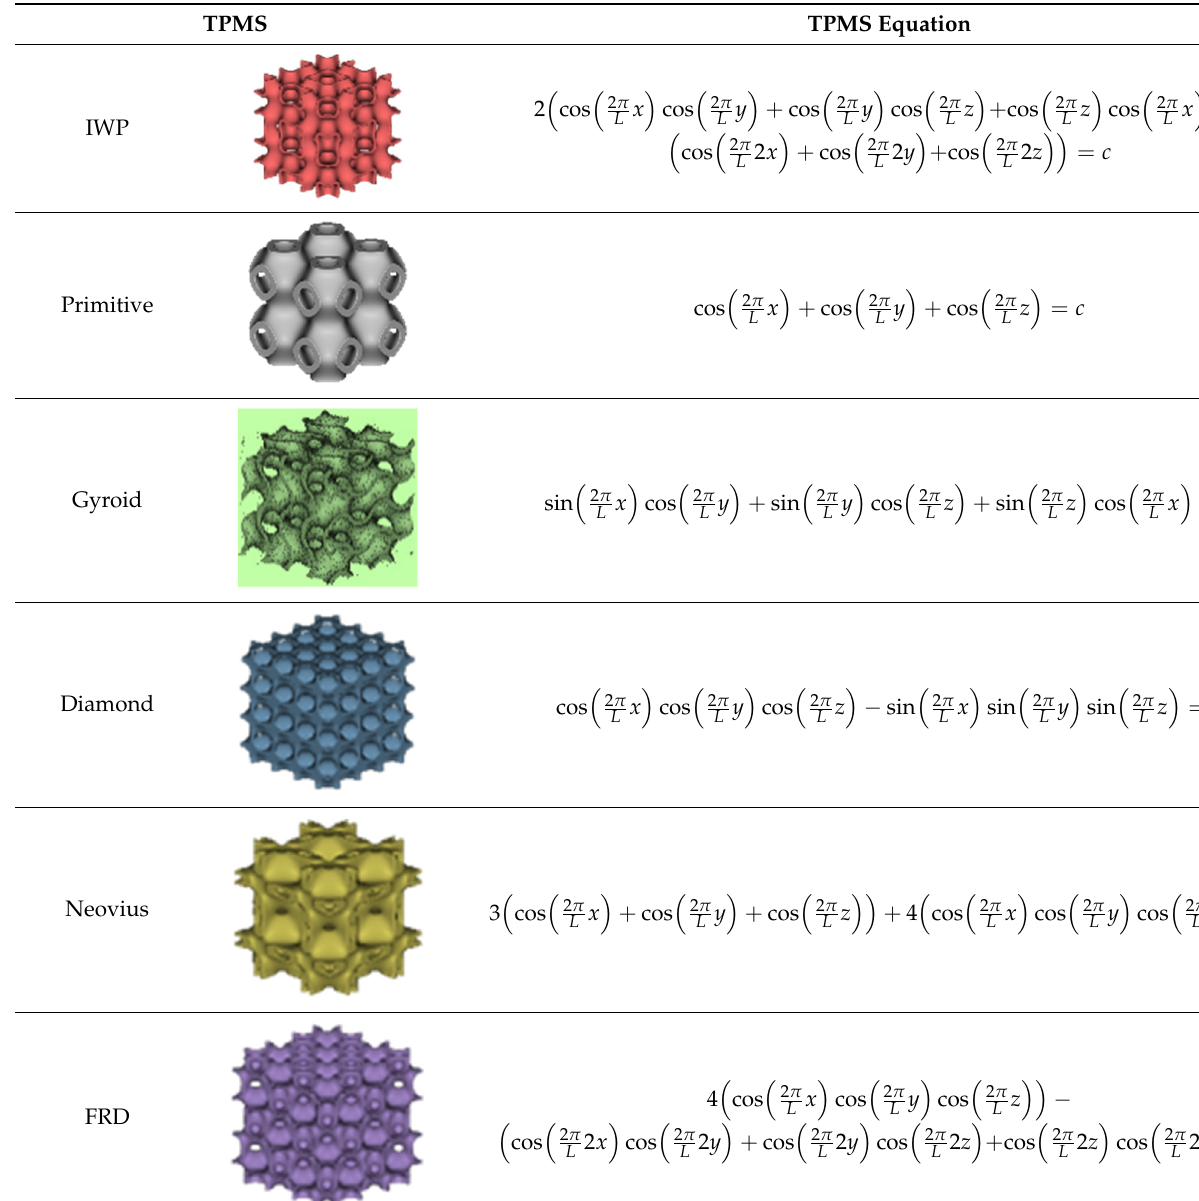
Table 1. TPMS structures and equations from a trigonometric approximation within Weierstrass Enneper formalism.